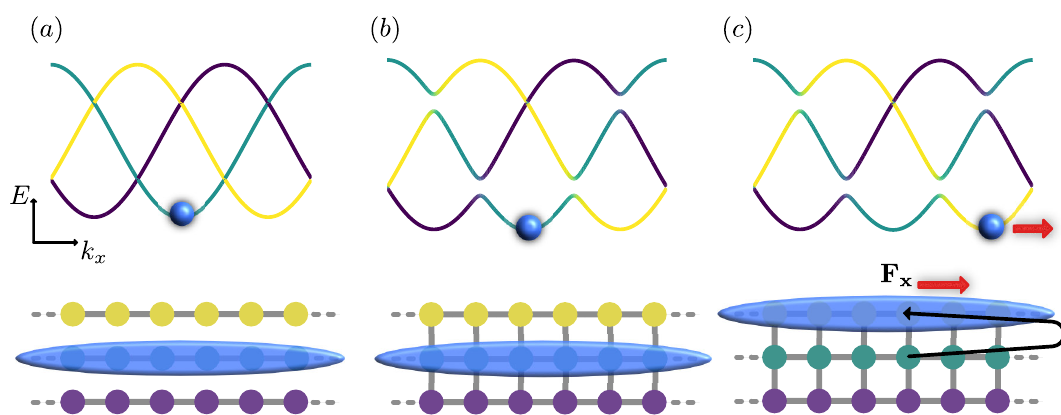
Figure 3: (a) Initially, the Hamiltonian has no tunneling in the y direction. The state is local- ized at y = 0. (b) The tunneling in the y direction is adiabatically turned on, opening gaps in the band structure. (c) Once the adiabatic loading is completed, a force F and the wave packet performs Bloch oscillations. The black arrow depicts schematically the motion of the center of mass over the first period of the force. After a complete period, the wave packet returns to the same position along x , but it has moved along y of a number of sites proportional to the Chern number of the corresponding energy